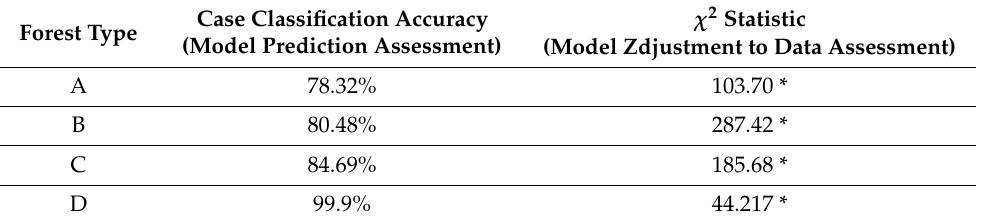
Table 10. Assessment of model prediction and adjustment to the